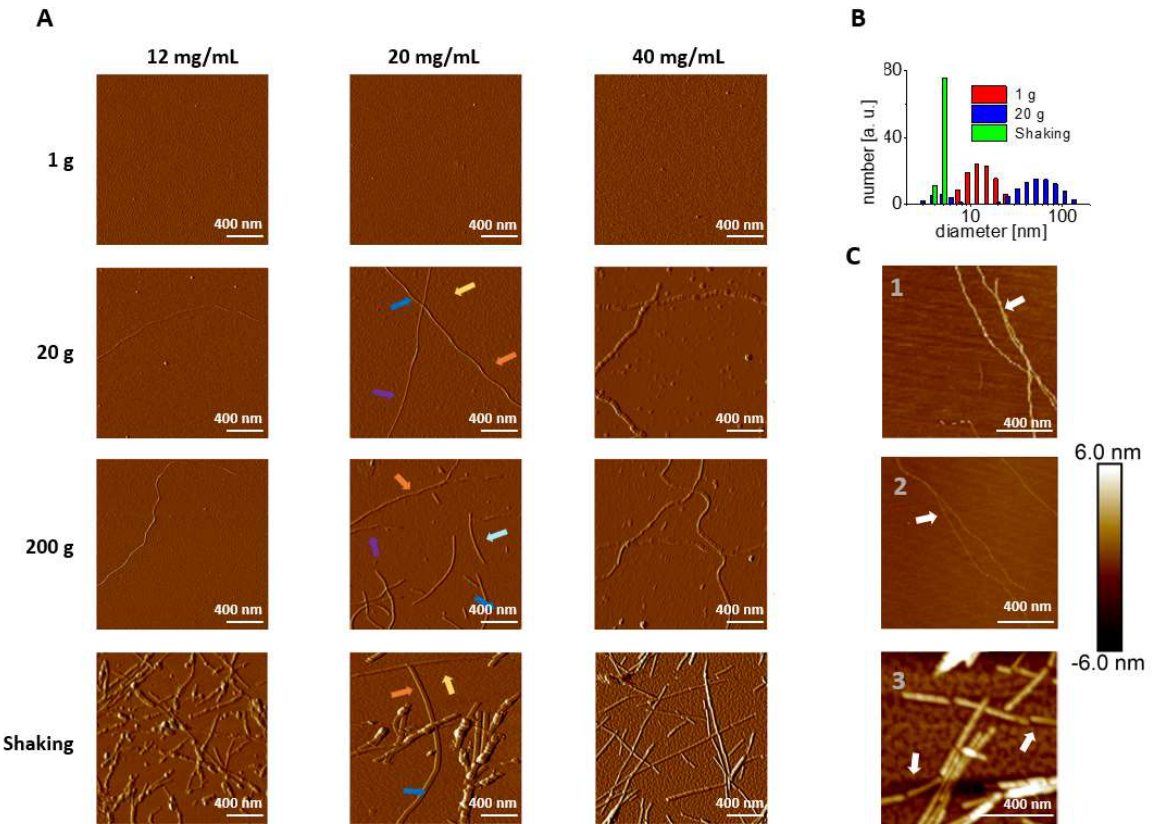
Figure 2. ( A ) Amplitude AFM images of lysozyme samples at pH 1.5 containing 15% ethanol at 12, 20, and 40 mg/mL after 8 days of incubation at 42 °C in 1 g, 20 g, 200 g, and shaking. The size of the images is 2 μm × 2 μm. The colorfed arrows indicate fibrils used in the morphology analysis. Images with a smaller magnification are given in Supplementary Information Figures S5 and S6. ( B ) Size distribution in the permeate from a 0.1 μm centrifugation filter of the entire fibrilization mixture in quiescent conditions, 20 g, and shaking determined by DLS. The fibrilization mixture contained 40 mg/mL of lysozyme at 42 °C in a solution at pH 1.5 with 15% ethanol. ( C ) Zoom-in of AFM height images of fibrillar aggregates from (1) centrifugation at 20× g ; the arrow indicates lateral assembly by protofilaments interwinding; (2) centrifugation at 200× g ; (3) shaking; the arrows indicate lateral assembly of separate, protofibril segments with a length of around 100–200 nm.